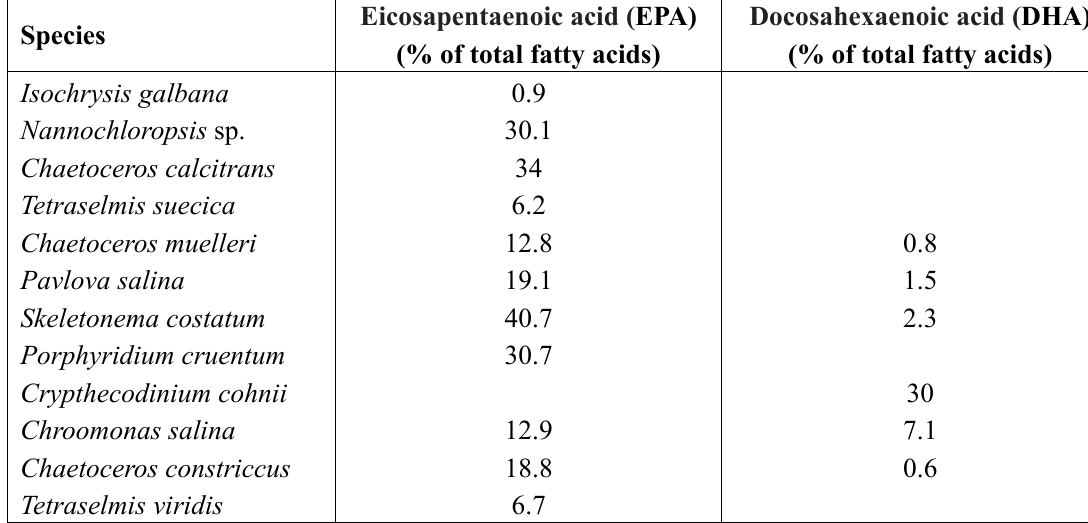
Table 4. Examples of potential microalgae species for omega-3 production